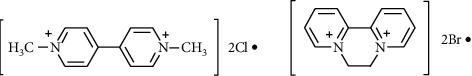
The structure of PQ and DQ.